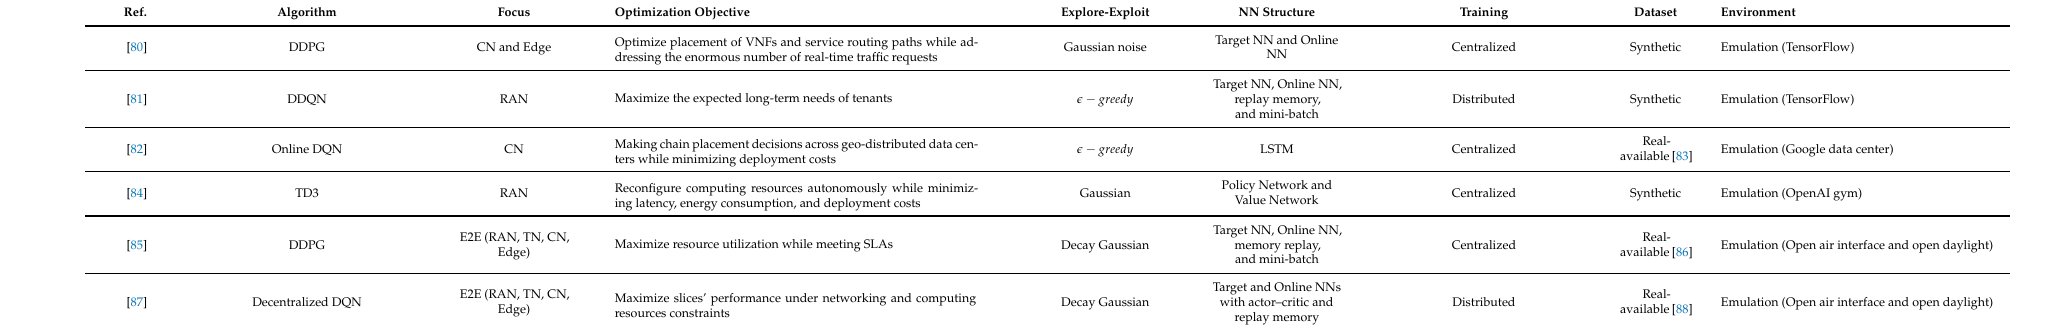
Table 4. Resource orchestration based on DRL.